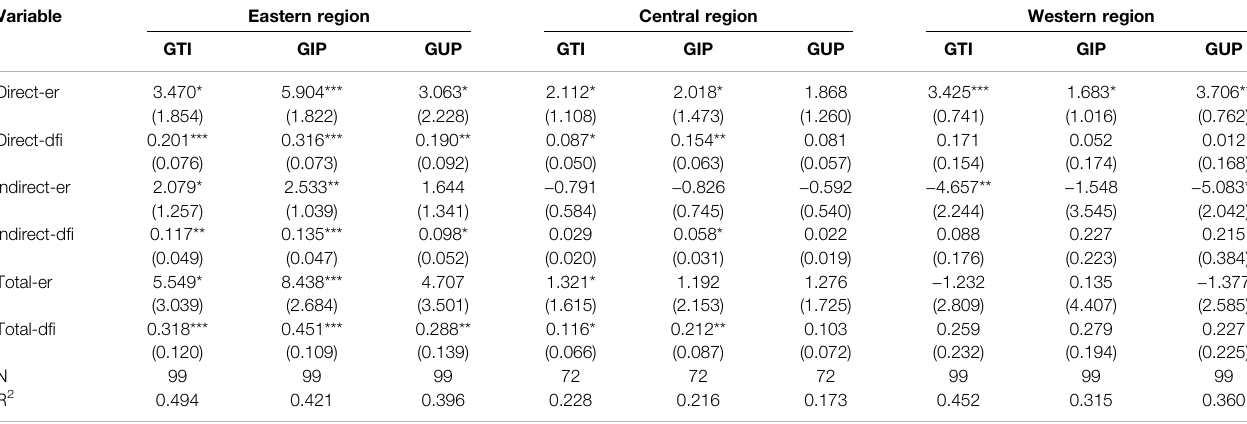
TABLE 5 | The estimation results for regional heterogeneity. Variable